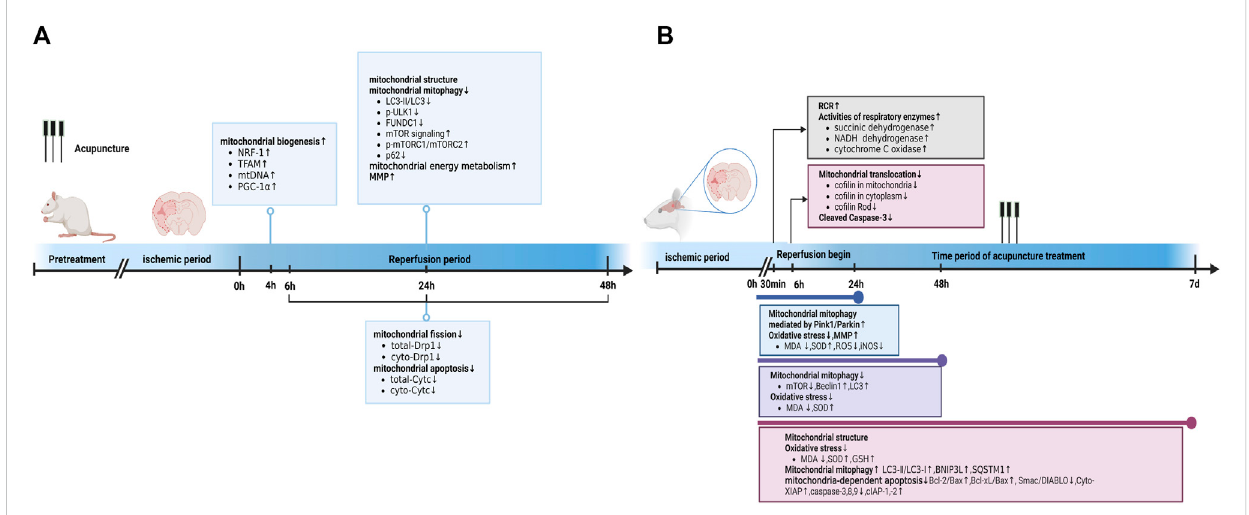
Acupuncture prevented and treated ischemic stroke by regulating mitochondria. (A) Acupuncture prevented ischemic stroke by regulating mitochondria at different time point in reperfusion stage. (B) Acupuncture treated ischemic stroke by regulating mitochondria at different time point of acupuncture treatment. Abbreviations: RCR, respiratory control ratio; LC3-I/II, Light chain 3I/II; GSH, glutathione; SQSTM1, Sequestosome-1; iNOS, inducible nitric oxide